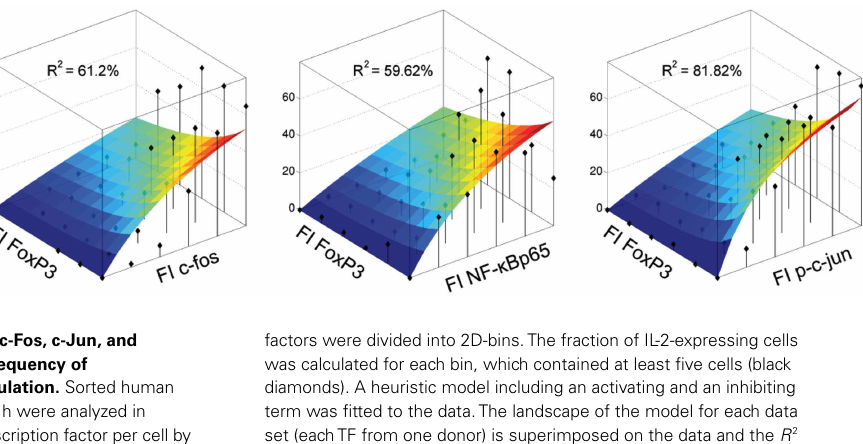
FIGURE 6 | Modeling confirms that NFATc2, c-Fos, c-Jun, and NF- κ Bp65 have an activating effect on the frequency of IL-2-expressing cells within the FOXP3 + population. Sorted human Treg cells stimulated with PMA/ionomycin for 5h were analyzed in parallel for IL-2, FOXP3, and one activating transcription factor per cell by flow cytometry.The normalized expression levels of the transcription